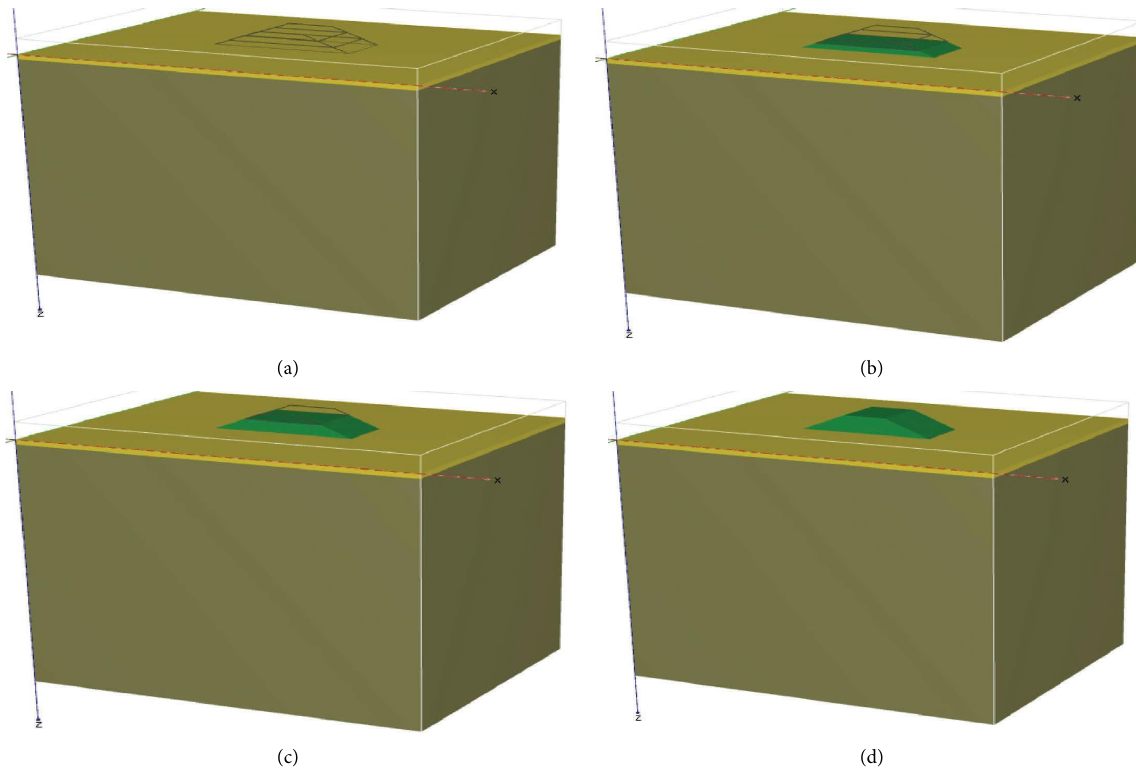
Figure 6: Phases of the staged construction: (a) initial phase (no fll), (b) the 1 st stage fll, (c) the 2 nd stage fll, and (d) the 3 rd stage